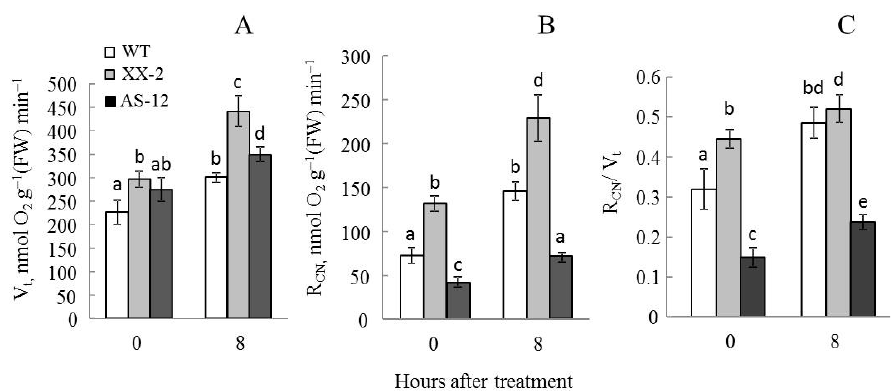
Figure 1. Total respiration rate (V t ) ( A ), KCN-resistant respiration (R CN ) ( B ), and relative part of R CN in V t ( C ) in leaves of wild type (WT), AOX1a -overexpressing (XX-2), and antisense (AS-12) Arabidopsis thaliana plants grown at 90 µ mol m − 2 s − 1 (0 h) and after 8 h of moderately high light exposure (400 µ mol m − 2 s − 1 ). Data are presented as mean ± SE of values from three independent experiments (n = 4–6 for each experiment). Significant differences between mean values (ANOVA, Duncan’s test, p < 0.05) are indicated by different letters (a, b, c, d, e). The same or double letters (ab, bd) indicate no significant differences between the means.